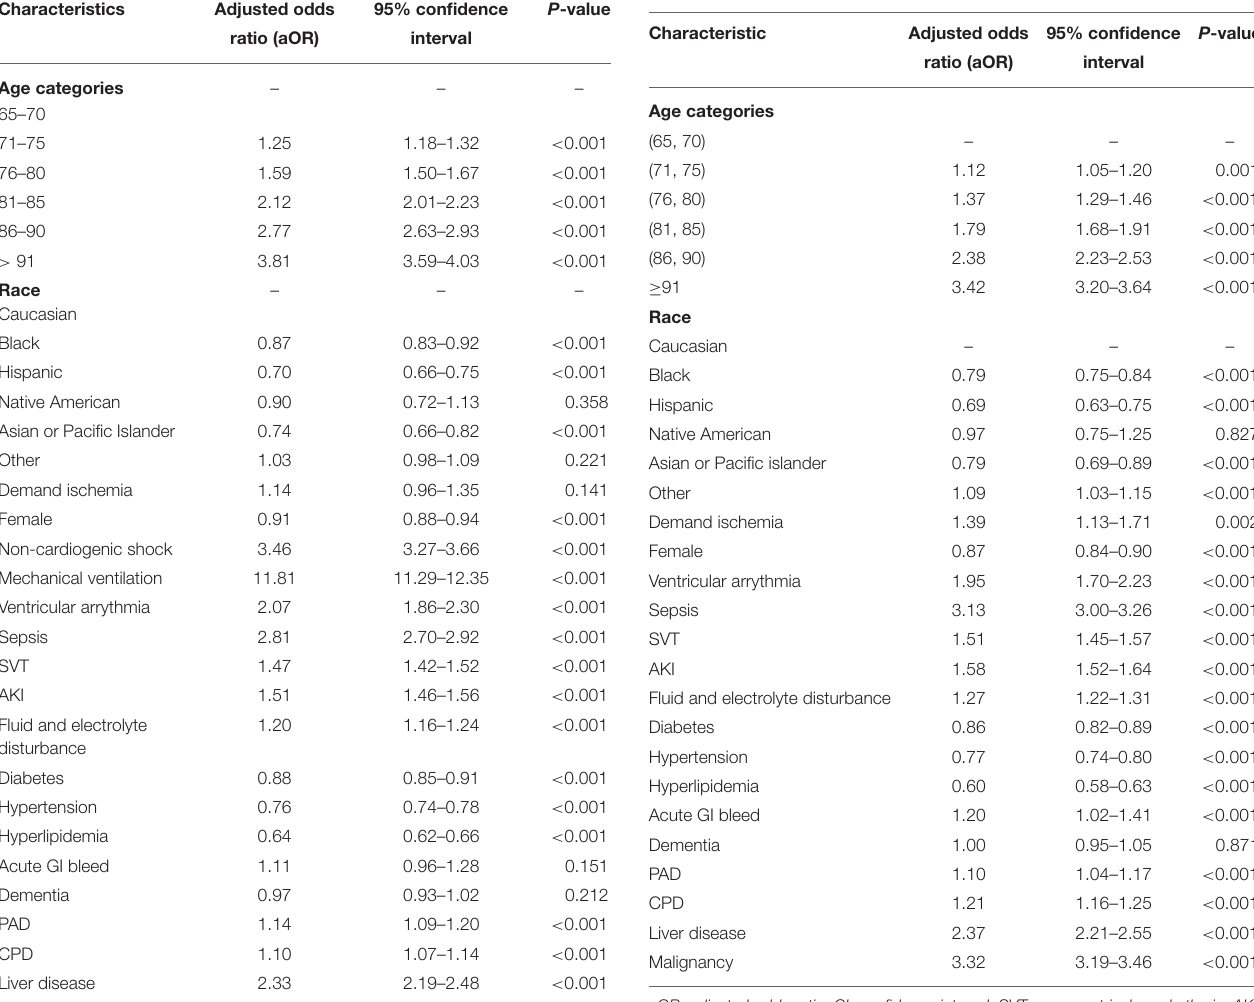
TABLE 3 | Association Between demand ischemia and in hospital mortality adjusting for demographics and clinically relevant characteristics in records without either non-cardiogenic shock or mechanical